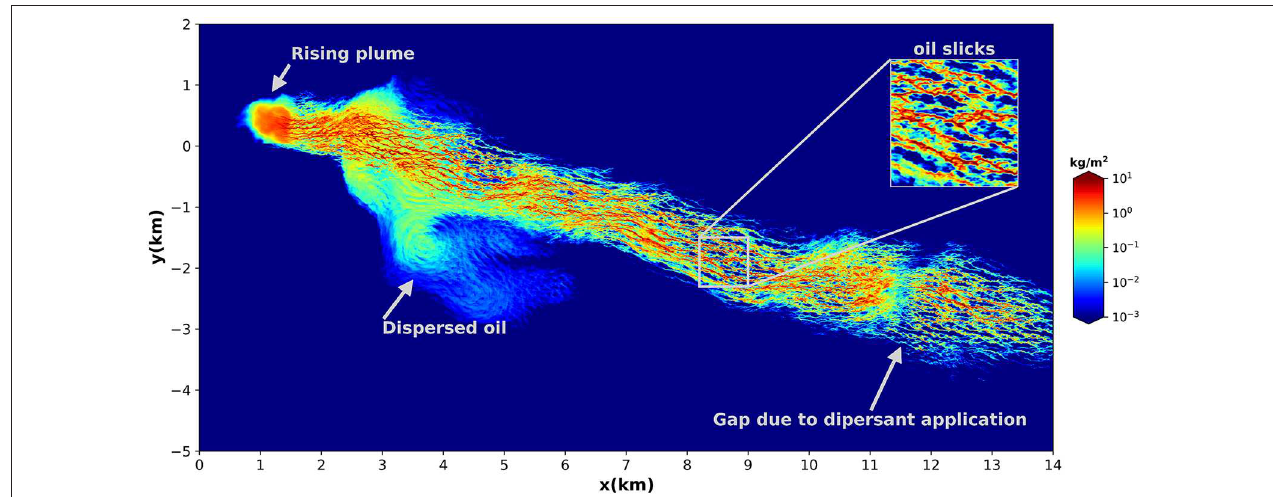
FIGURE 14 | Patterns of total oil mass in the ocean mixed layer produced by the multiscale large-eddy simulation model 36 h after the application of dispersant in a small target area on the surface. The portion of the slick impacted by the dispersant (“dispersed oil”) disconnects from the main plume, being transported in a different direction at much lower speed (from Chen et al., 2018). Note the similarity of the patterns to those shown in Figure 1B .